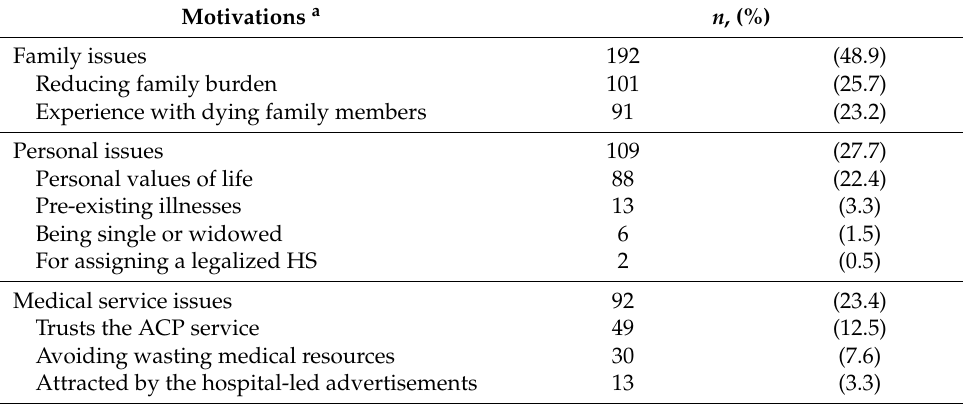
Table 3. Motivations for